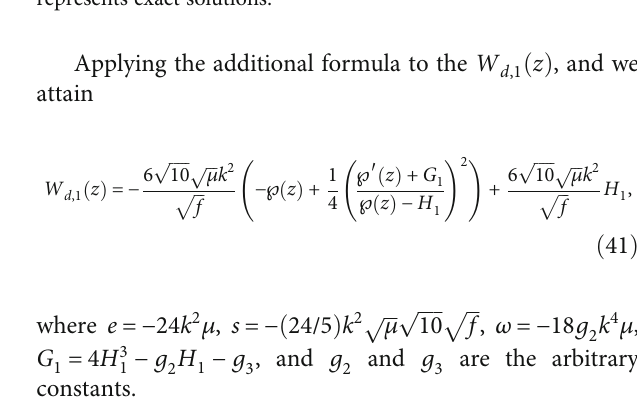
𝜋 ð z Þ for the fi xed s ,2